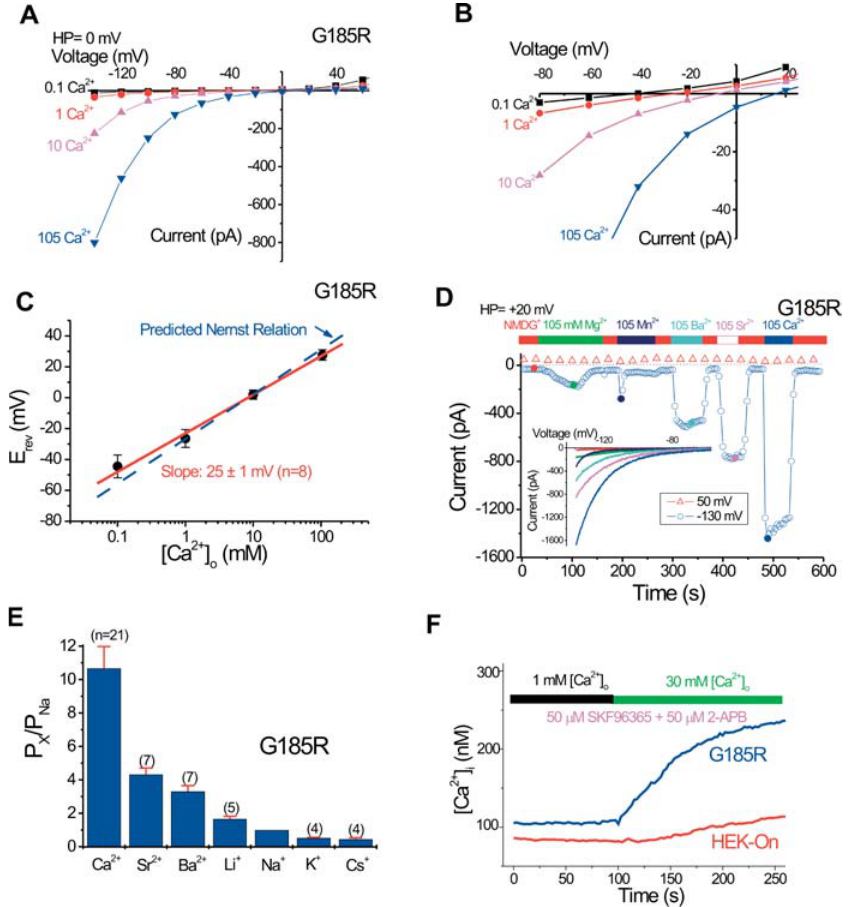
Figure 3. Ca 2 þ Permeability of I